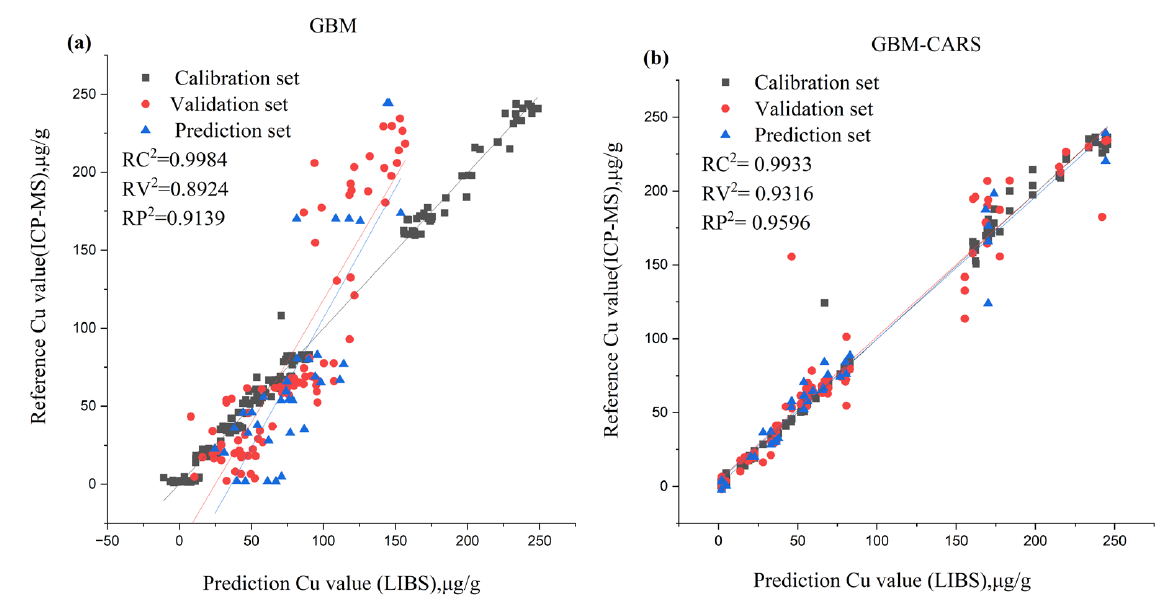
Figure 5. ( a ) Scatter plots of the full variables and reference value ( b ) Scatter plots of GBM combined with CARS feature selection method and reference value for the content of Cu.